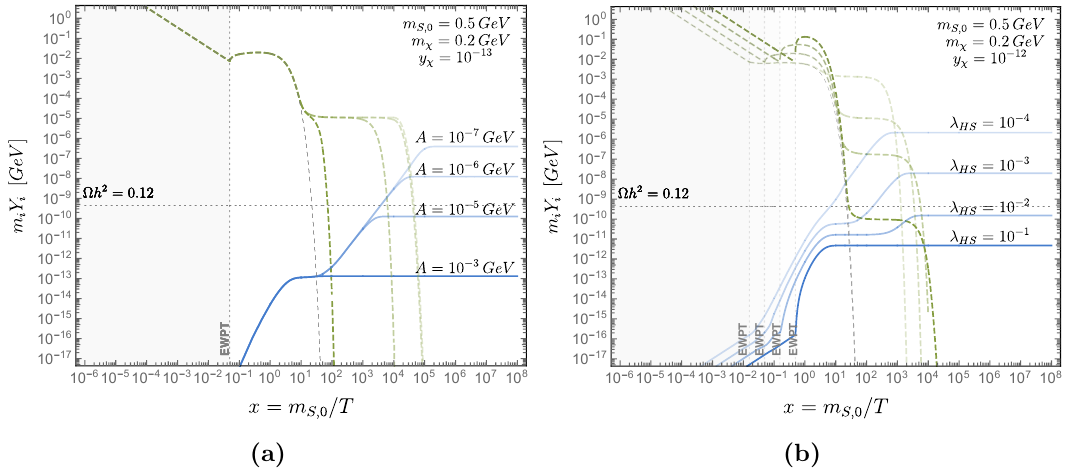
) governs the branching ratio HS (for (cid:12)xed A ). Lowering (cid:21) HS HS S